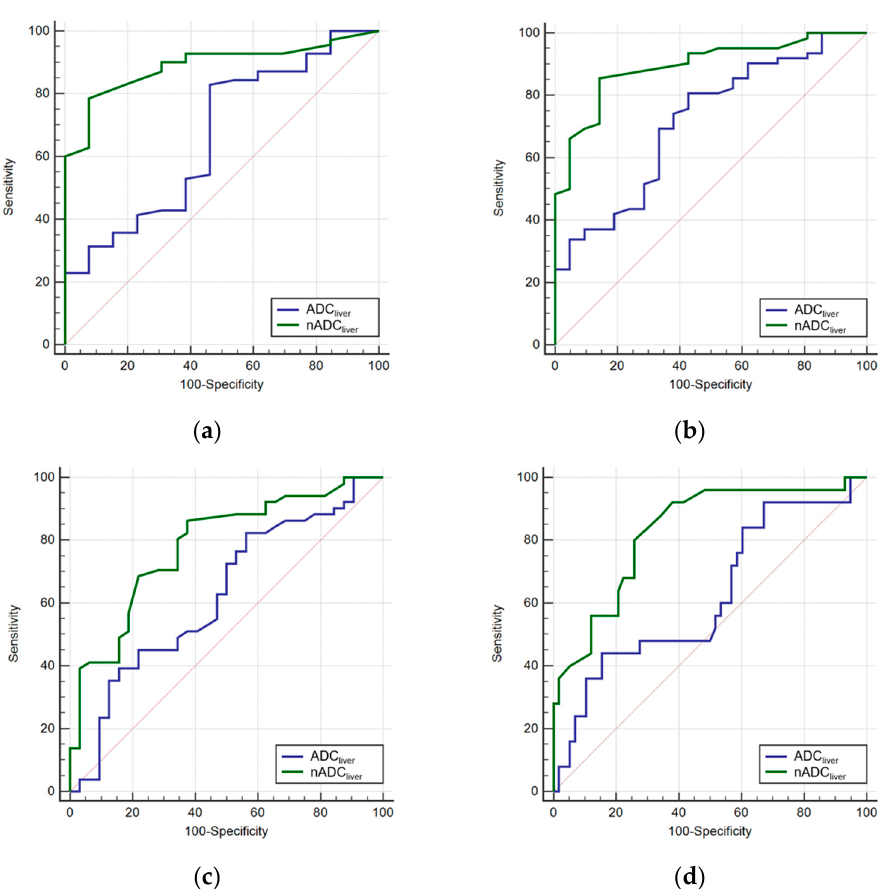
Figure 3. Comparison of receiver operating characteristics curve for diagnosing fibrosis stage ≥ F1 ( a ), ≥ F2 ( b ), ≥ F3 ( c ), and F4 ( d ) on liver ADC (ADC liver ) and normalized ADC (nADC liver ) .